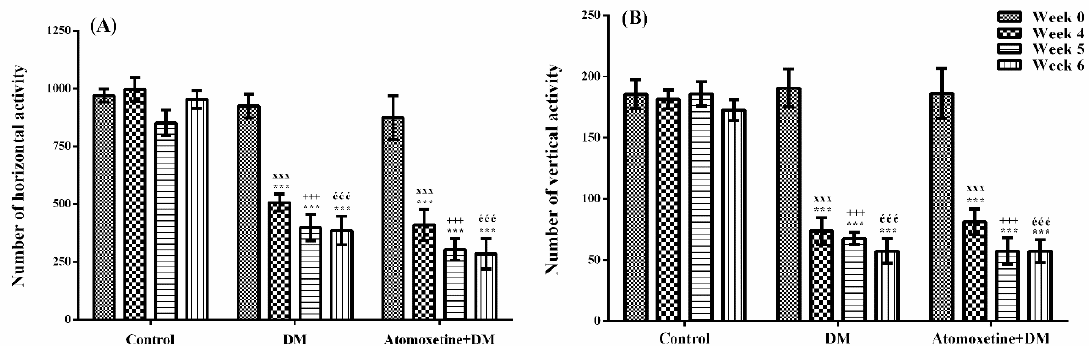
Figure 8. Total number of horizontal ( A ) and vertical ( B ) locomotor activities of normoglycemic rats administrated physiological saline (Control), and of diabetic rats administrated daily 3 mg/kg atomoxetine (Atomoxetine + DM), in the activity cage test. Values are given as mean ± S.E.M. Within the groups: significant difference against Week 0 group is *** p < 0.001. Between the groups: significant difference against Week 4 control, Week 5 control and Week 6 control groups are xxx p < 0.001; +++ p < 0.001, and ééé p < 0.001, respectively. Two-way repeated ANOVA, post hoc Bonferroni test, n = 8.